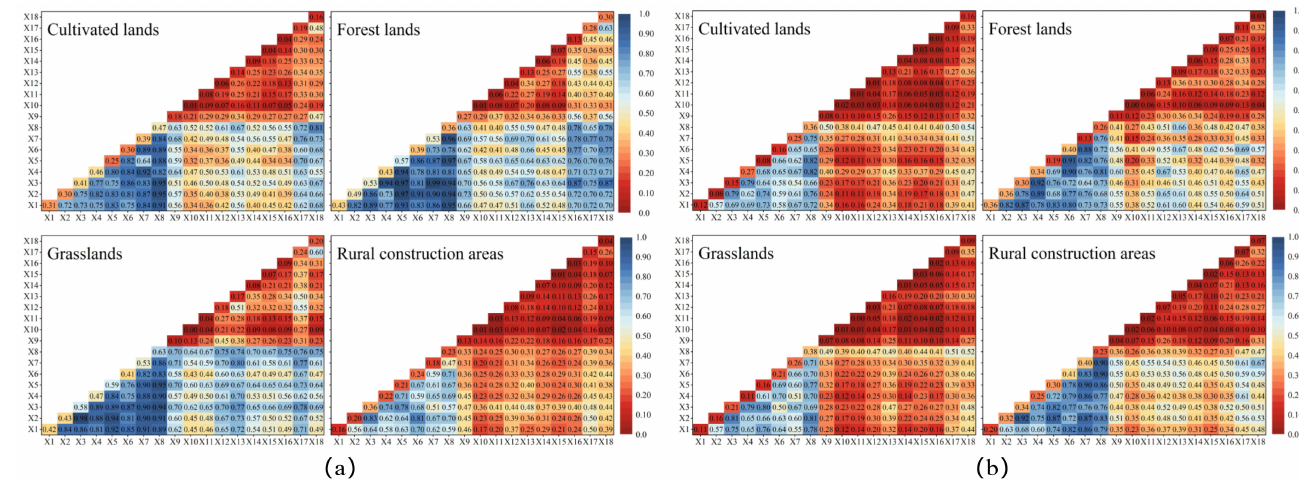
Figure 7. Interaction detection of LUCC drivers from 2000 to 2010 ( a ) and 2010 to 2020 ( b